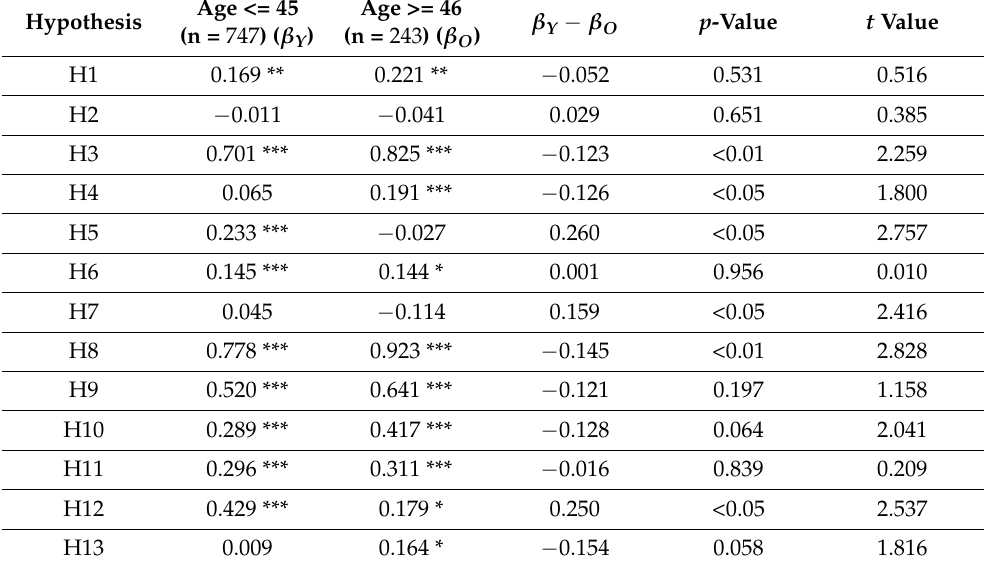
Table 8. Multi-group analysis by age.